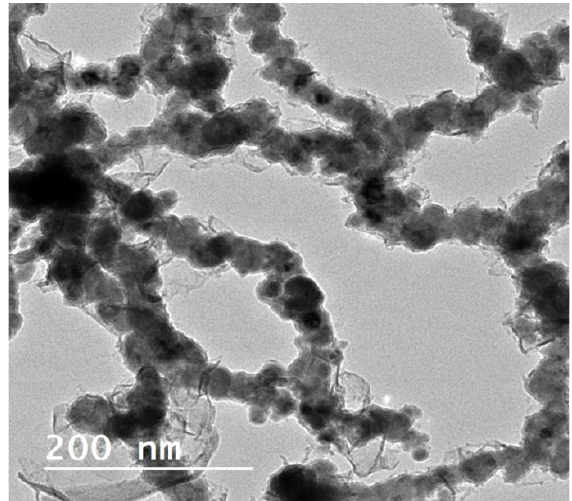
Figure 2. TEM image of ZVI nanoparticles.